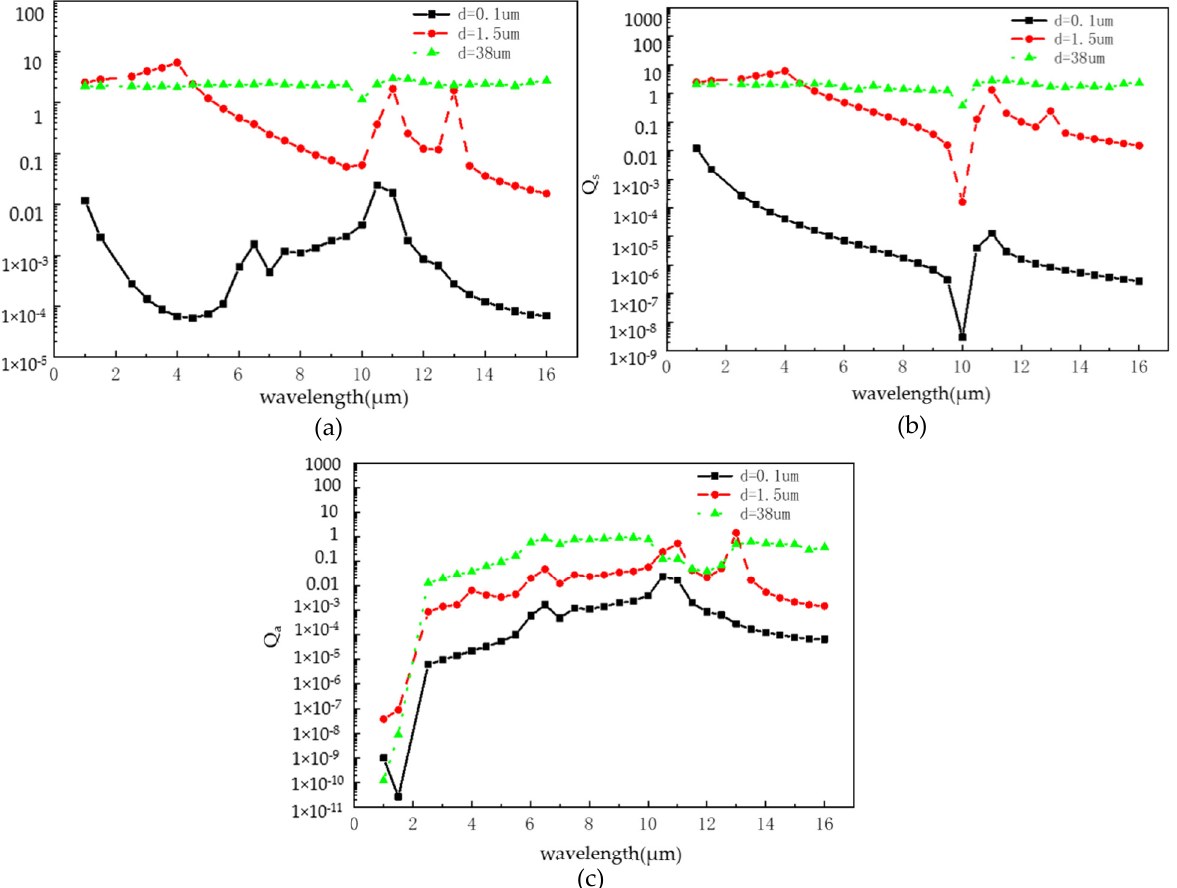
Figure 4. The extinction factor, scattering factor and absorption factor of SiC particles with different scale changes at different wavelengths: ( a ) extinction factor (Q e ); ( b ) scattering factor (Q s ); ( c ) ab- sorption factor (Q a ).